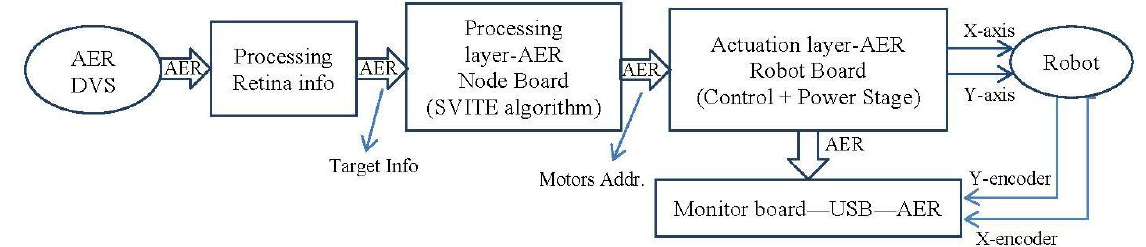
Figure 11. Model of the setup shown in Figure 10. The AER retina delivers the addresses of spiking pixels. Then, just the address of the tracking object’s center is fed as the target position to the architecture; it is split for both algorithms which control each axis. The encoders are used just to provide information about the movement of each axis. All the arrows represent AER